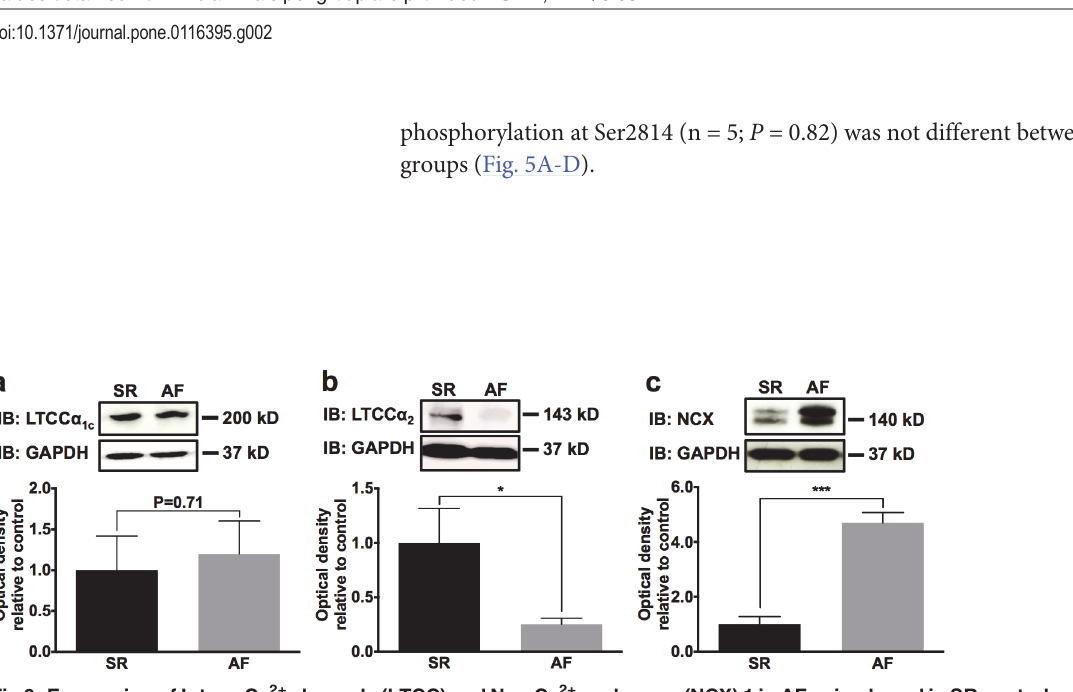
Fig 3. Expression of L-type Ca 2+ channels (LTCC) and Na+-Ca 2+ exchanger (NCX) 1 in AF animals and in SR controls. a, b Regulatory LTCC α 2 subunit was significantly downregulated in AF animals, whereas the pore forming α 1c subunit was not affected. c AF lead to significant upregulation of the NCX1 transporter. Representative Western blots and mean ( ± SEM) optical density data normalized to GAPDH are displayed (n = 5 animals per group). * P < 0.05; *** P < 0.001.